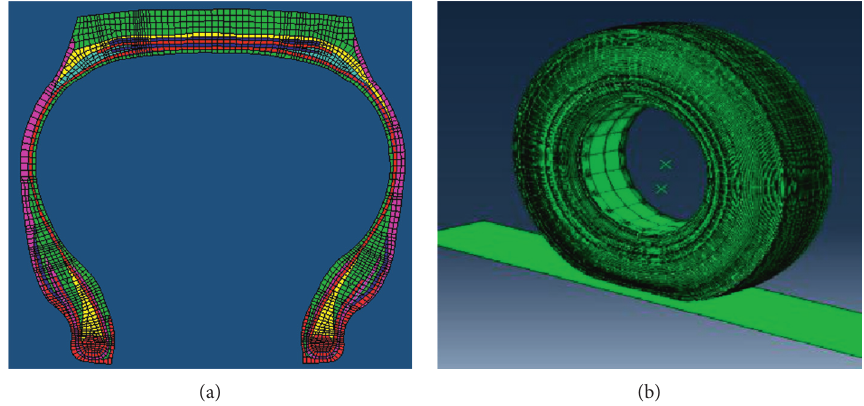
Figure 4: Finite element model. (a) Two-dimensional finite element model. (b) Three-dimensional finite element